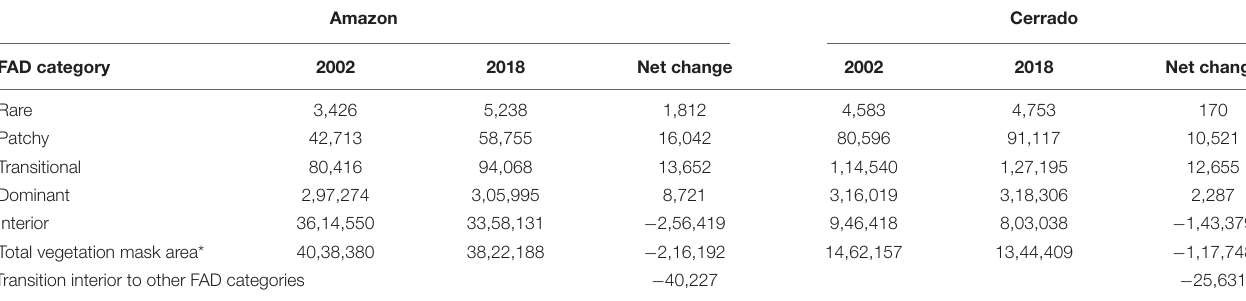
TABLE 1 | Area (km 2 ) and net change for each Forest Area Density (FAD) category in 2002 and 2018 for Amazonia and the Cerrado.